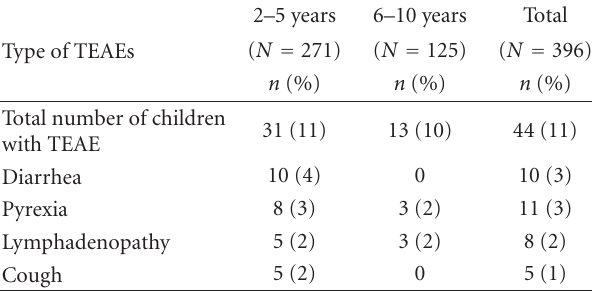
Table 3: TEAEs observed in at least 1% of the patient